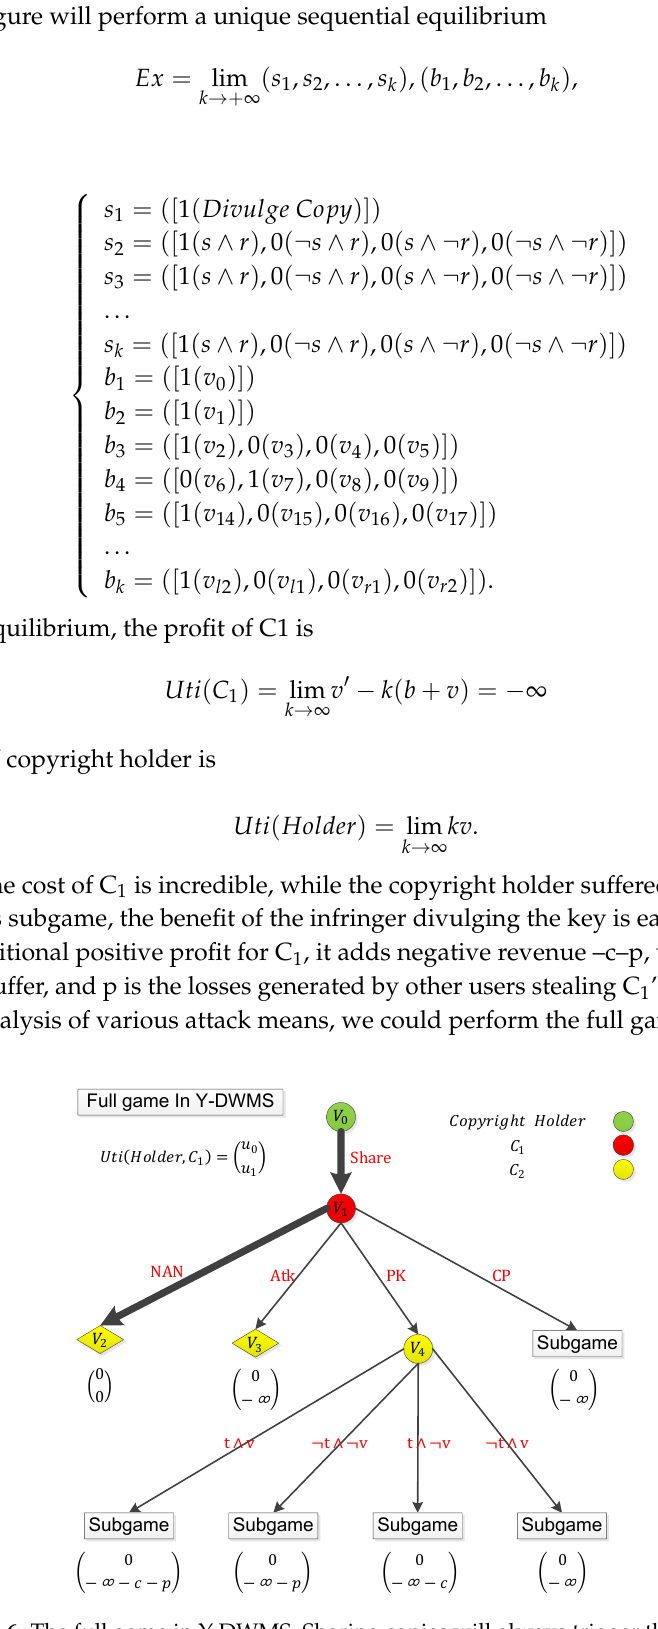
Figure 6. The full game in Y-DWMS. Sharing copies will always trigger the